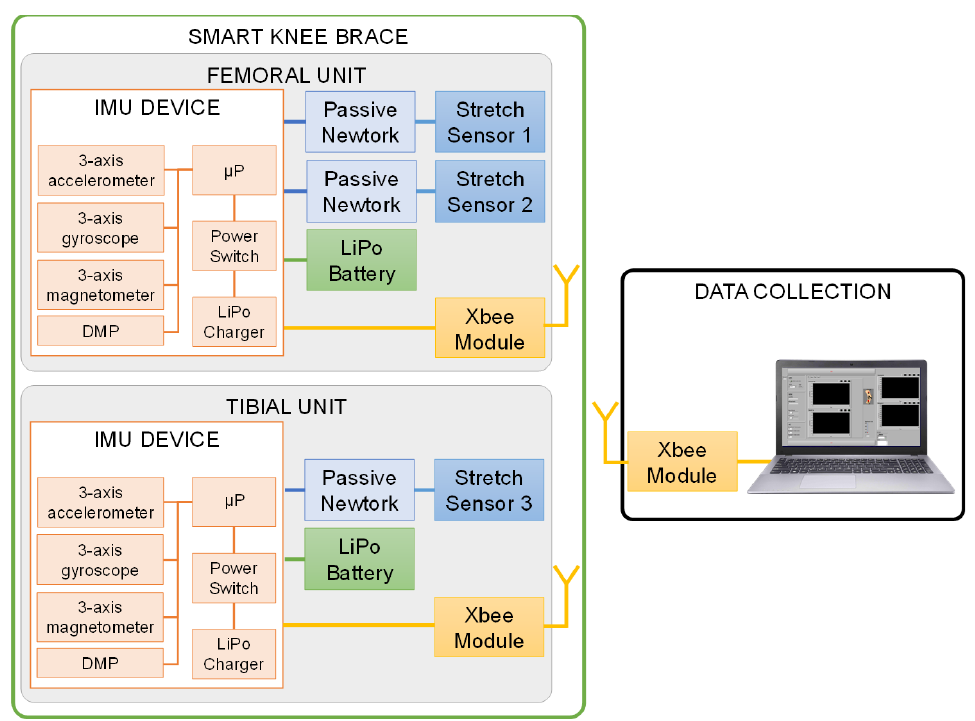
Figure 2. Block diagram of the smart knee brace and the data collection system.